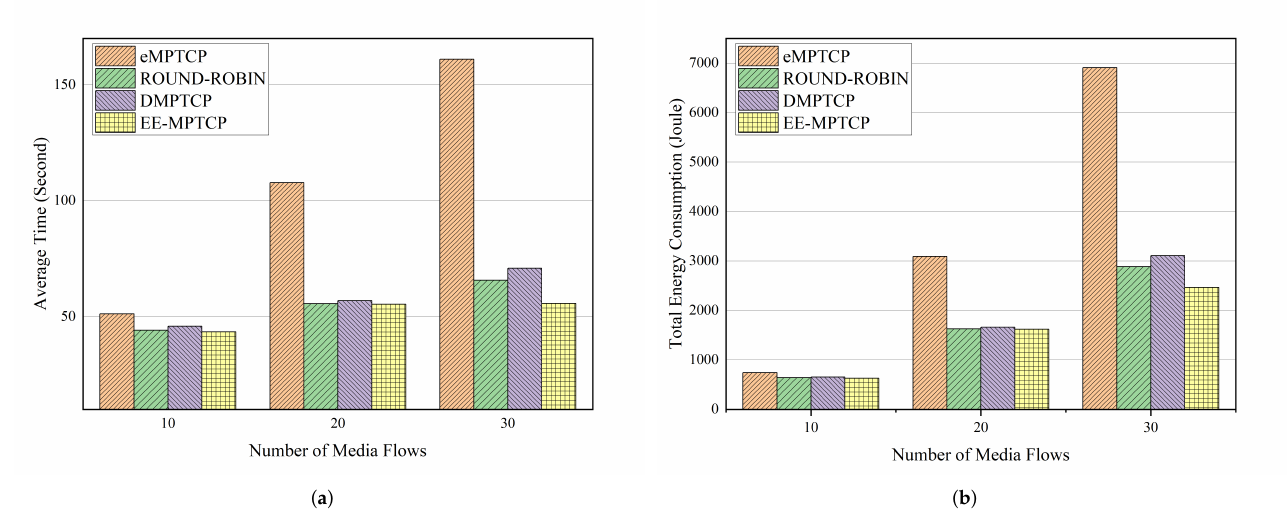
Figure 6. The evaluation results of the four algorithms, namely eMPTCP [14], the default ROUND- ROBIN, DMPTCP [27] and the proposed EE-MPTCP with varying number of media flows with the size of 1 MB that transmitted concurrently in the network environment that consists of one LTE